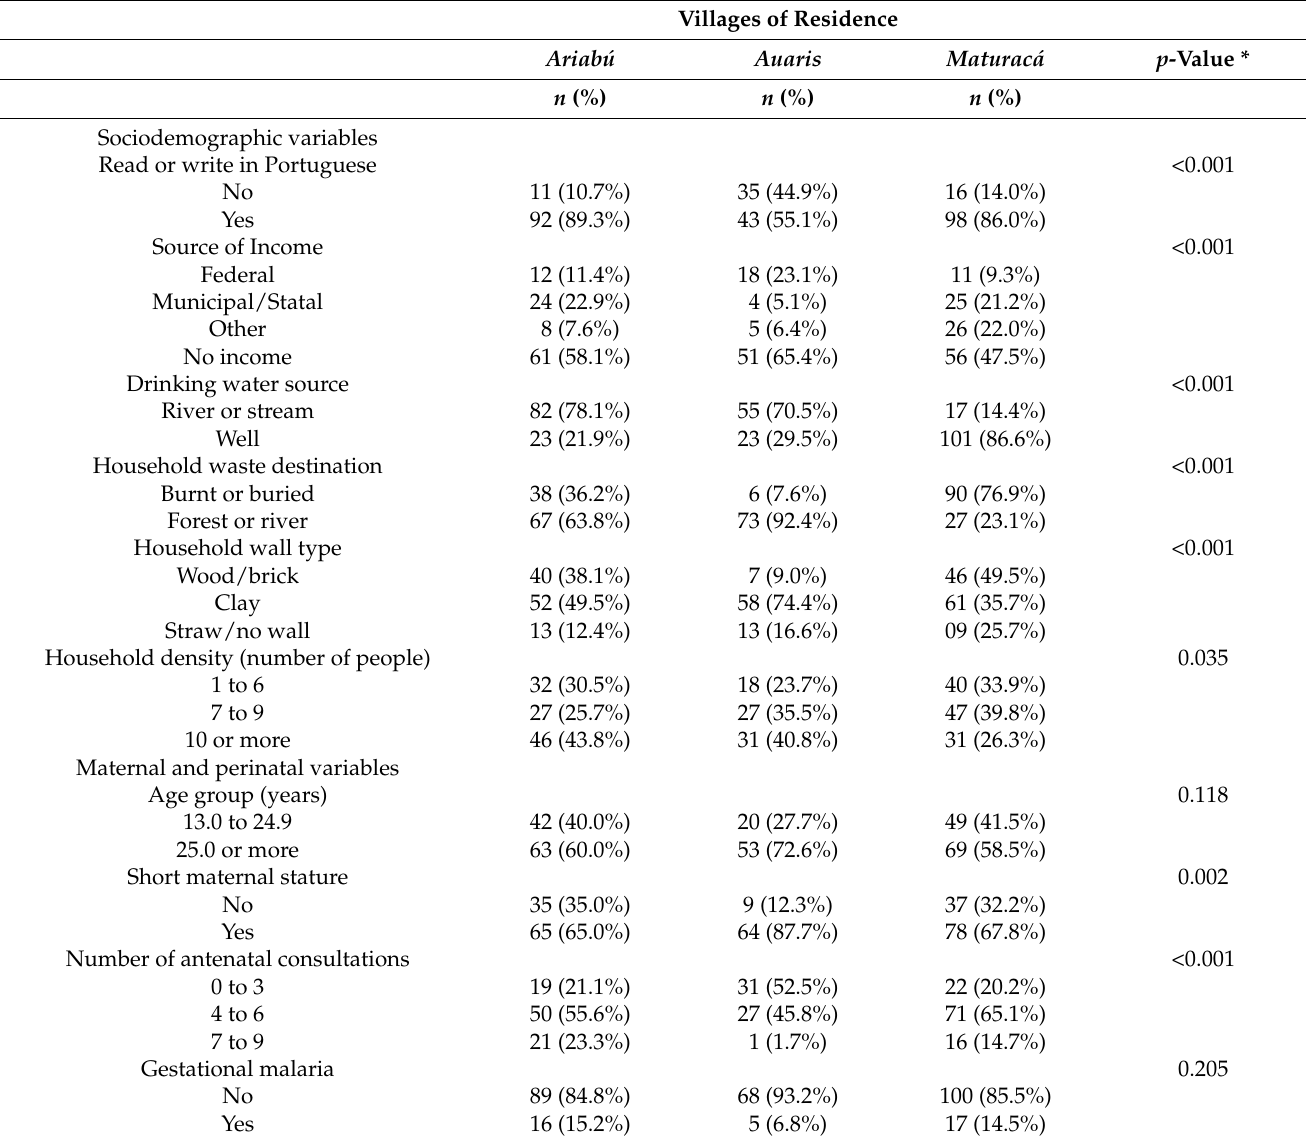
Table 2. Sociodemographic, maternal and children under five years of age characteristics, according to the village of residence. Yanomami Indigenous Territory, Brazilian Amazon,